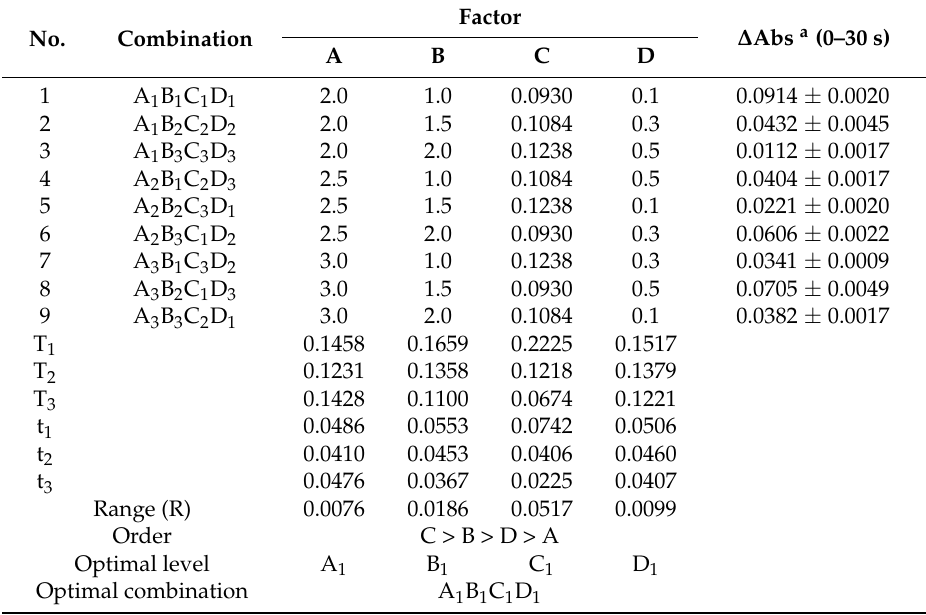
Table 2. Orthogonal array (9, 3 4 ) for the analysis of the effects of ATP, AMP, bromothymol blue, and glycine–NaOH buffer on the Adk activity